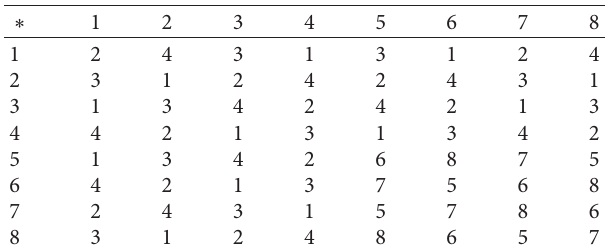
Table 9: Table of Example 9.